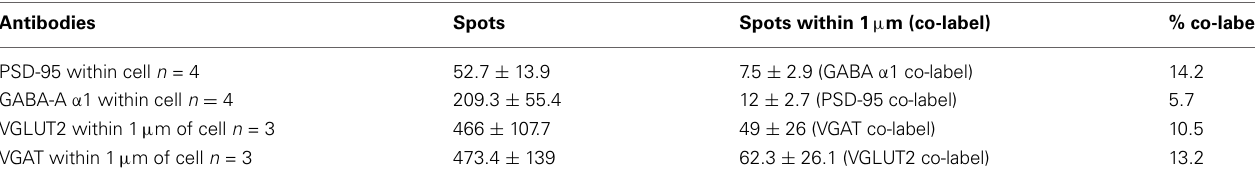
Table show spots of excitatory (PSD-95) and inhibitory (GABA-A α 1) post-synaptic specializations within the same Neurobiotin-filled neuron somas and the number of spots of each synapse type within 1 μ m of each other. Also shown are spots of excitatory (VGLUT2) and inhibitory (VGAT) pre-synaptic specializations within 1 μ m of Neurobiotin-filled neuron somas and the number of spots of each synapse type within 1 μ m of each other. Data presented as mean ± SEM.